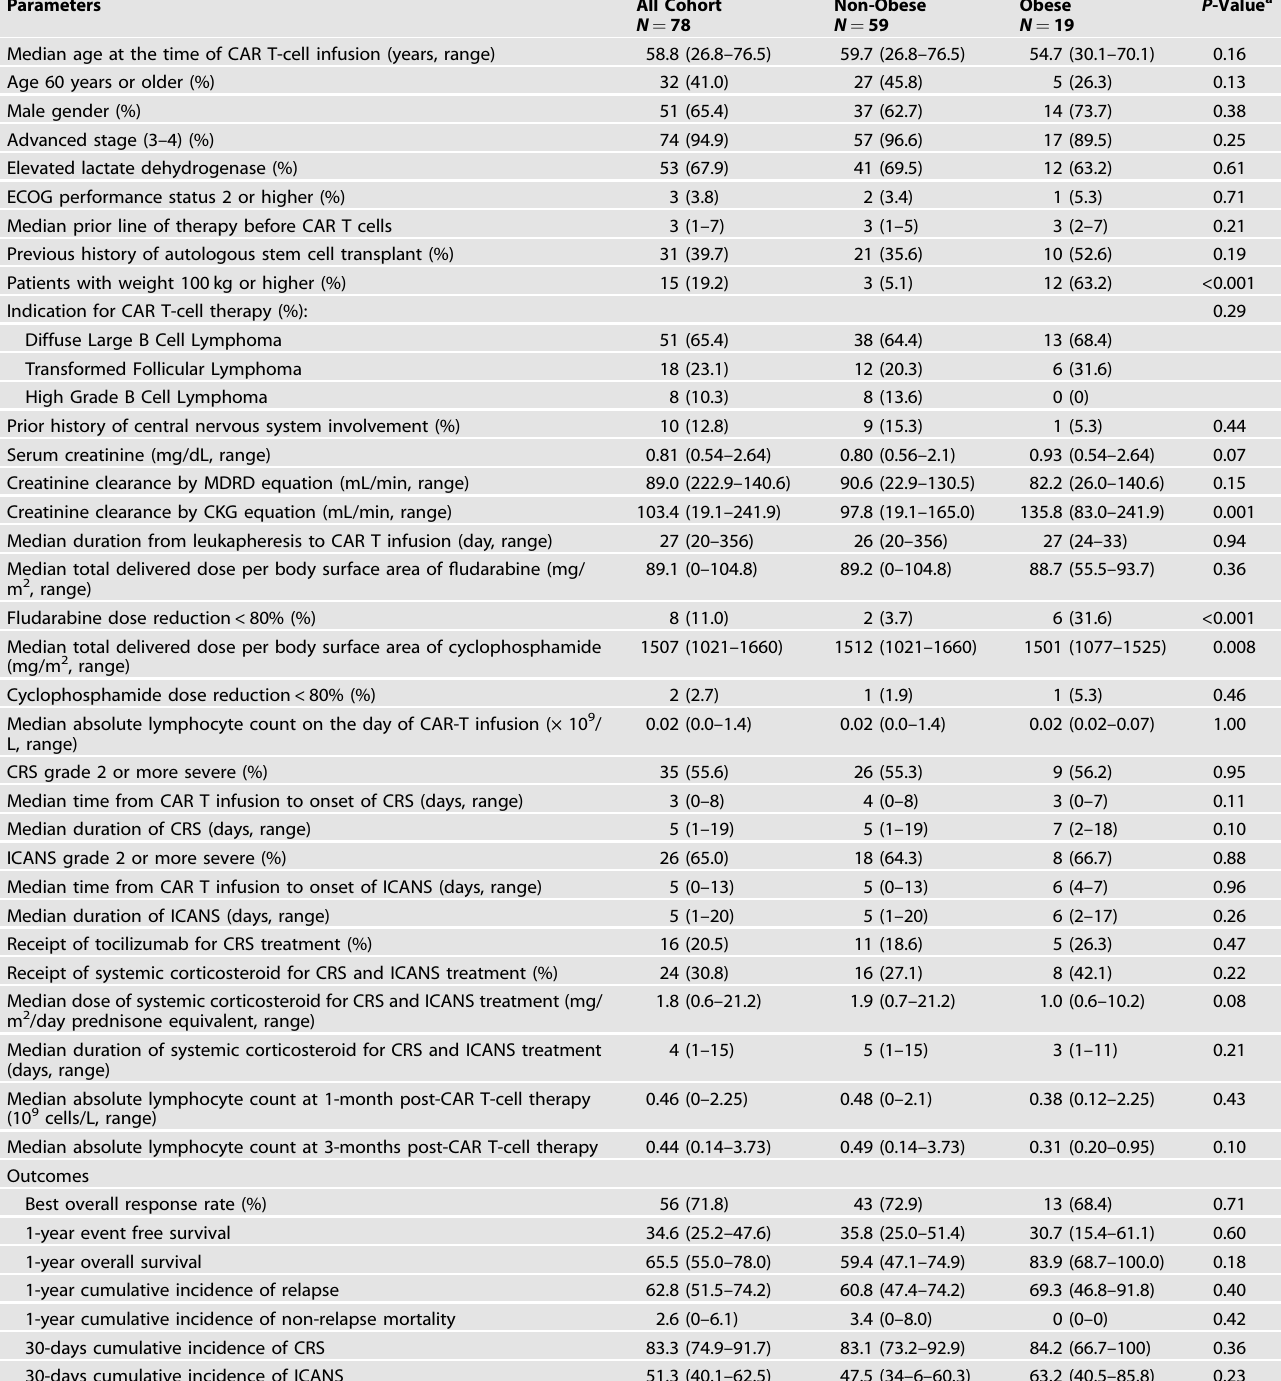
Table 1. Characteristics and outcomes of patients with aggressive B-cell lymphoma treated with axicabtagene ciloleucel as strati fi ed by obesity